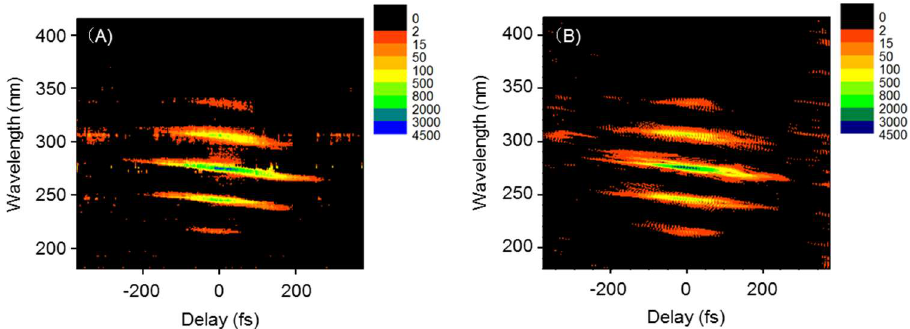
Figure 3. FROG trace. ( A ) Original data ( B ) retrieved data. A fused silica plate (10 μm) was used as the SD material.